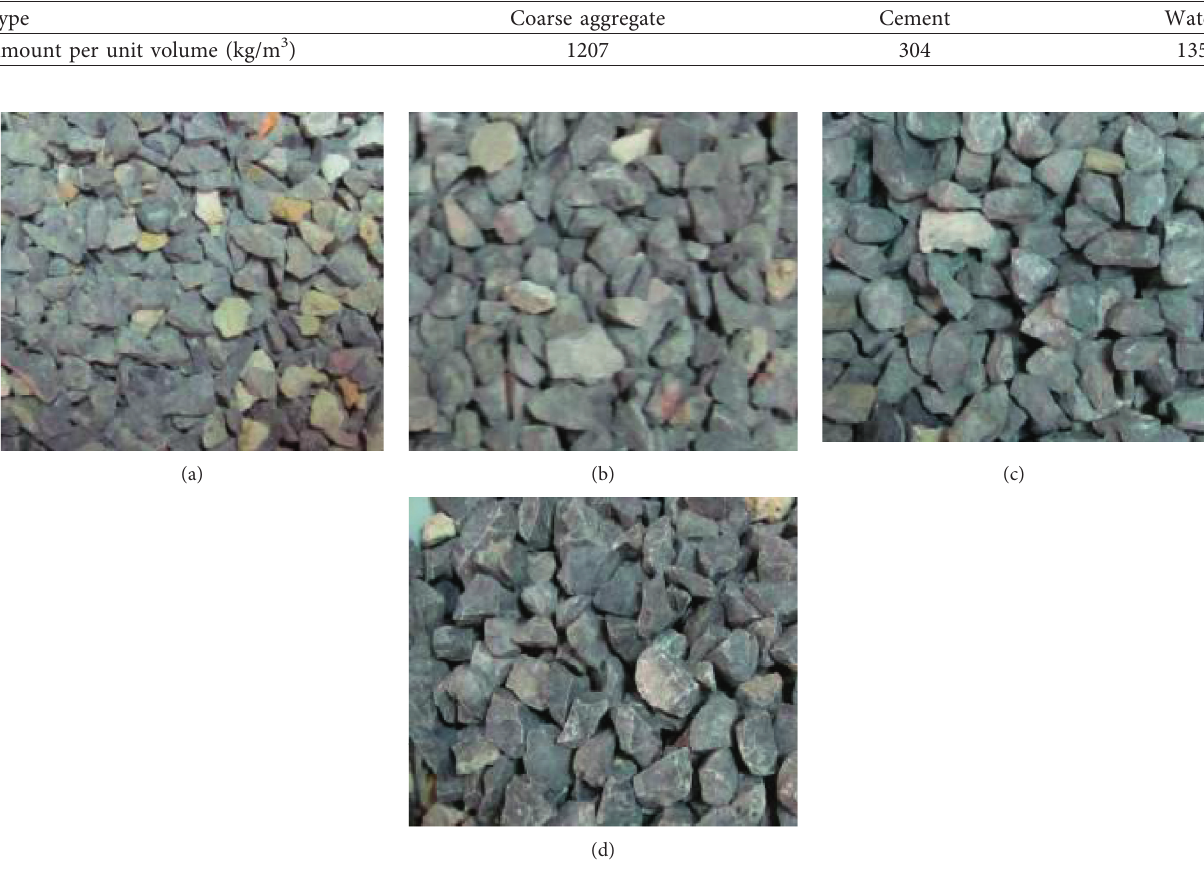
Figure 1: Different grain diameters of coarse aggregate: (a) 4.75mm, (b) 9.5mm, (c) 13.2mm, and (d)